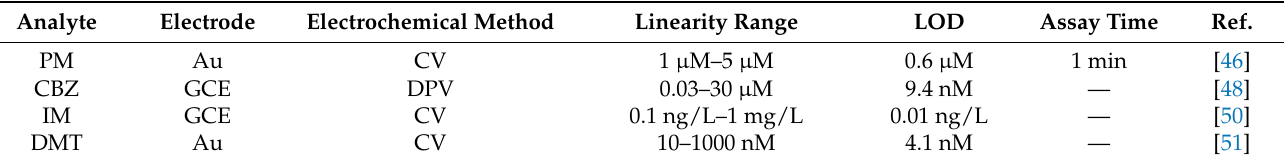
Table 5. Electrochemical biosensors for pesticide residue detection.